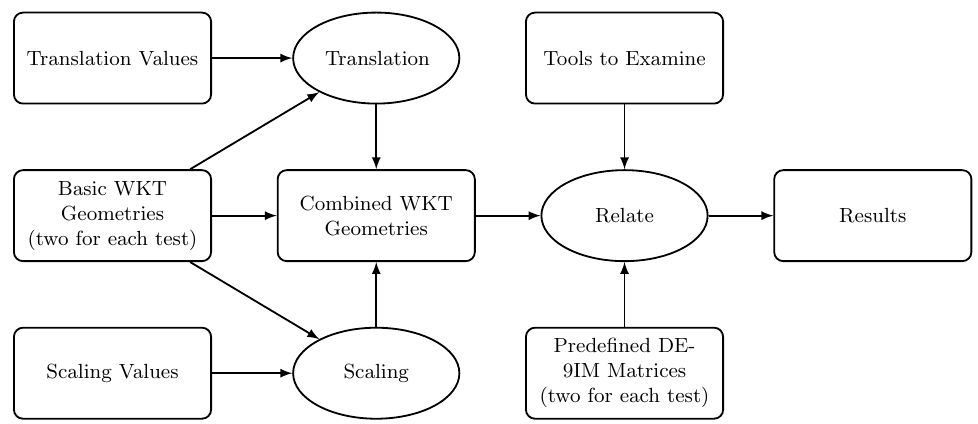
Figure 11. Test procedure in rough diagram